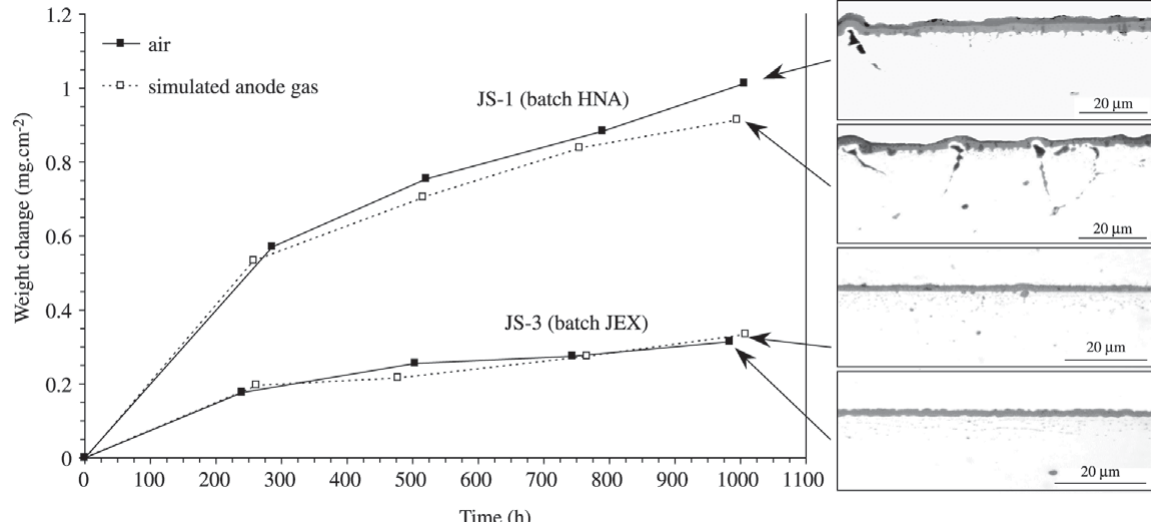
Figure 2. Oxidation behaviour of selected model ferritic steels at 800 °C in air and Ar-4%H